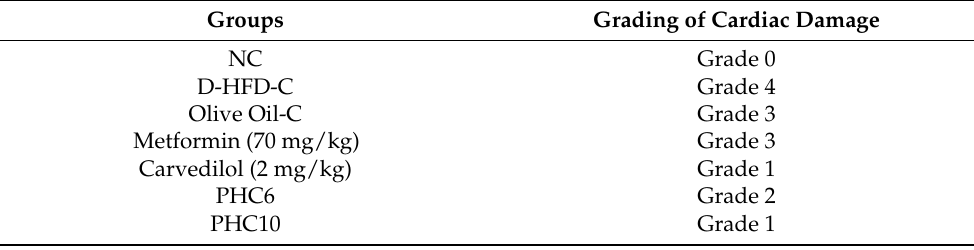
Table 5. Grading of